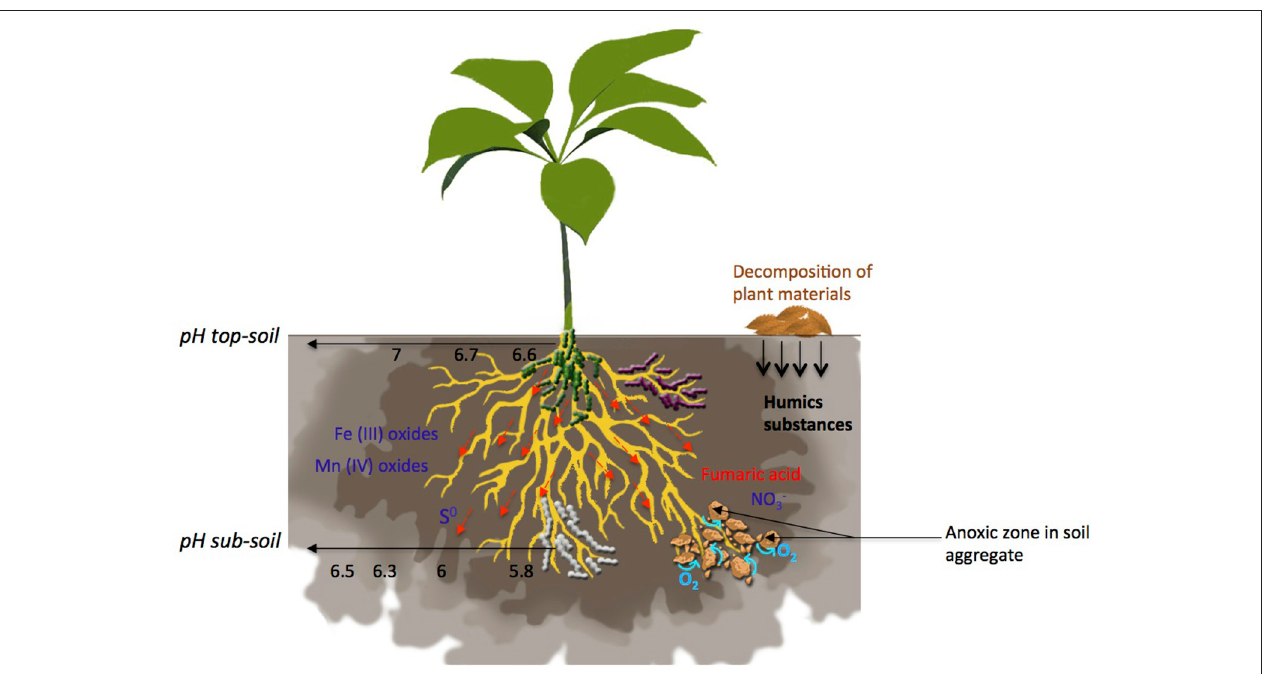
FIGURE 1 | Terminal Electron Acceptors (TEAs) distribution, O 2 flux and pH gradient in the rhizosphere. Many factors are involved in the formation of zones favorable for anaerobic respiration establishment such as TEAs availability, pH, water movement and soil aggregate formation. NO − 3 moves freely within the soil, with a vertical gradient of availability from sub-soil to top-soil. Decomposition of plant materials leads to the release of humic substances. Fumaric acid is exuded by plant roots. Availability of Fe(III), Mn(IV) and S 0 is mostly driven by pH. Roots influence pH leading to a gradient from an acidic pH close to the roots to a neutral pH in the rhizosphere. Anoxic zones occur in soil aggregates and in soils submitted to water